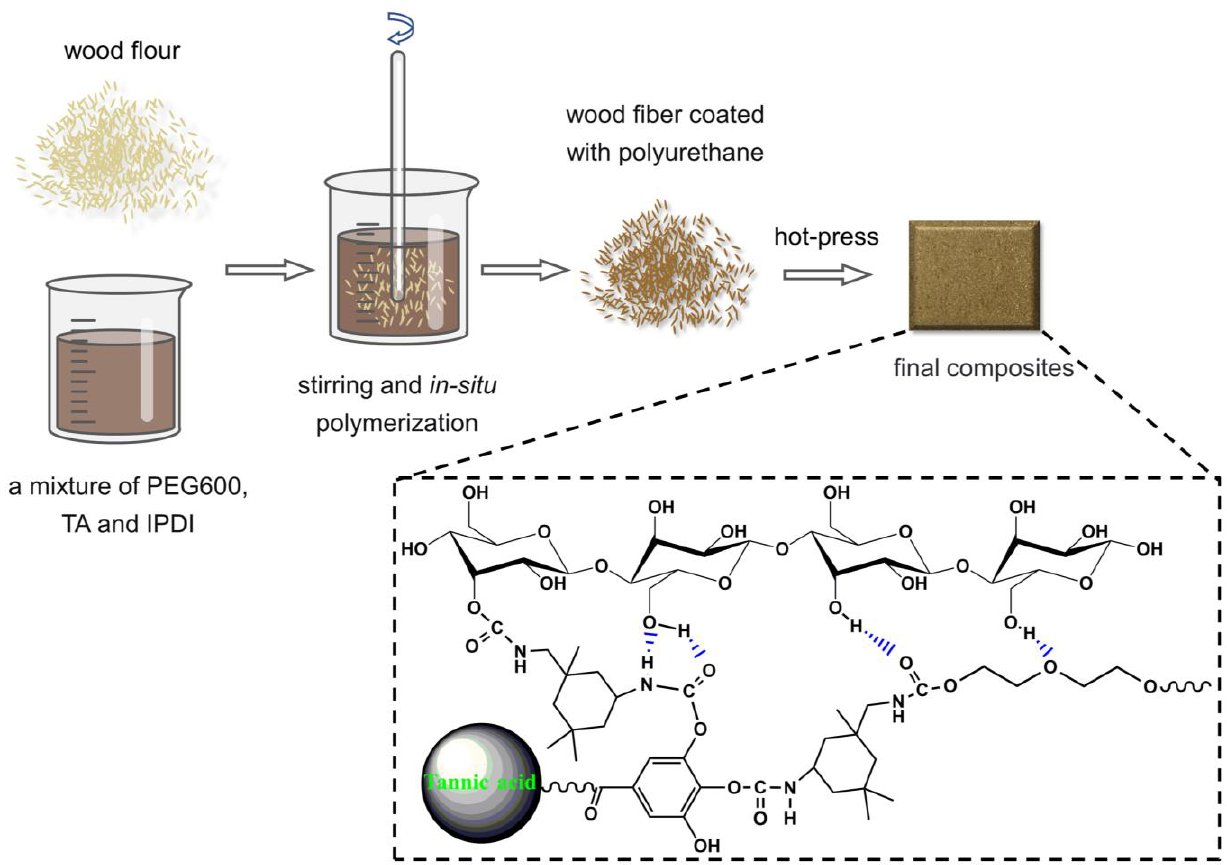
Figure 1. Schematic representation of the preparation of the UWPU composites.